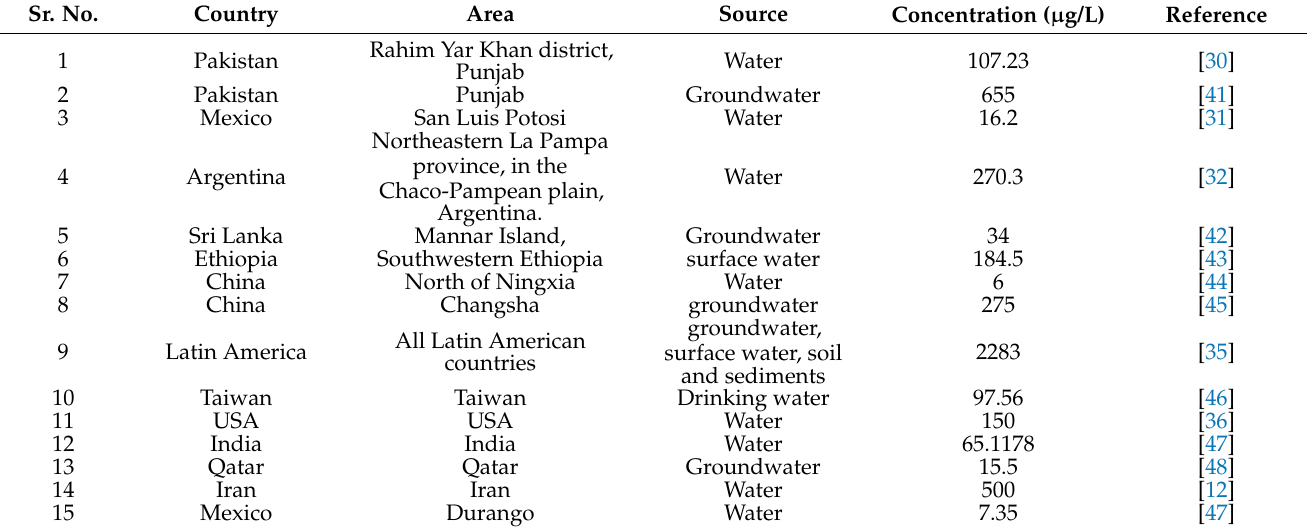
Table 1. Documented groundwater arsenic concentration in different